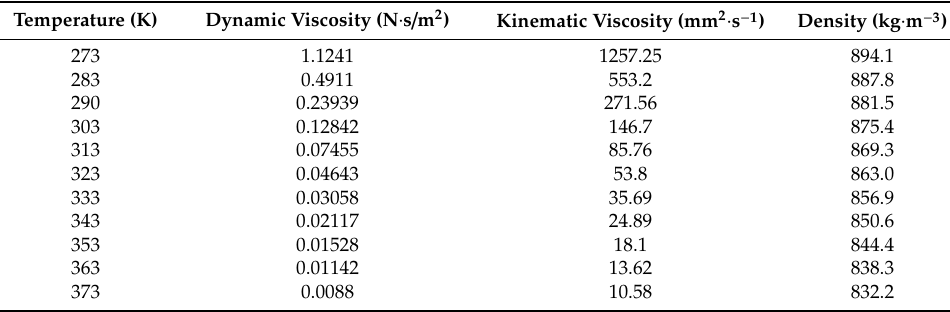
Table 2. Characteristics of the fluid at normal temperature.